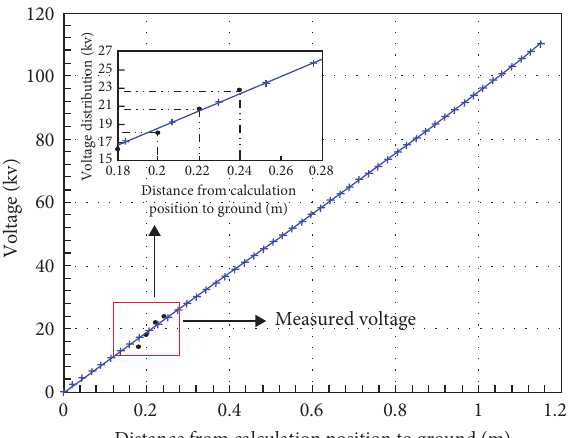
Figure 5: Voltage distribution of the test